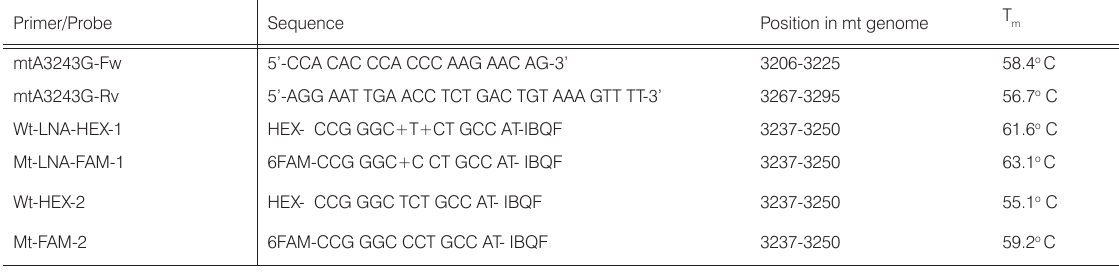
Table 1. Sequences and melting temperature of primers and probes used in real-time PCR